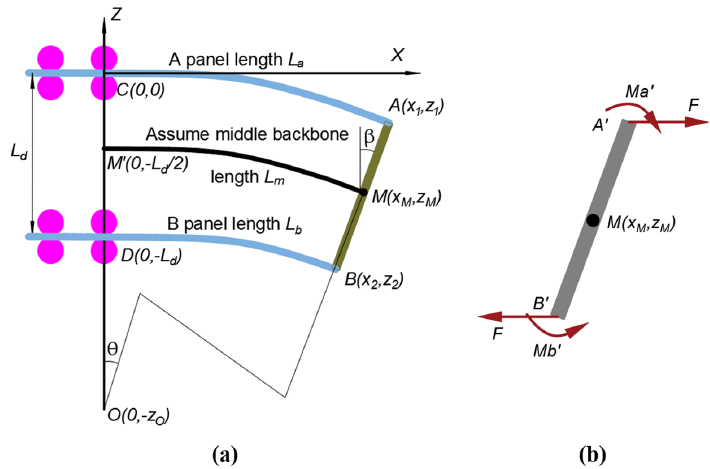
Figure 4. Planar parallel continuum robot and static analysis of the moving platform: ( a ) A virtual backbone that runs through the middle axis of the two panels; ( b ) A pushing force at point A and a pulling force at point B. (cid:1) Table 1 records the experimental data in terms of panel lengths L a and L b . In the ex ‐ periment, both panels start from 150 mm and end at 400 mm. In total, there are five series with an increment of 50 mm for L b , and within each series L a changes in an increment of 50 mm. For series 1, L b is at the initial position of 150 mm and L b changes from 200 mm to 400 mm in an increment of 50 mm. For series 2, L b advances to 200 mm and L a changes from 250 mm to 400 mm in an increment of 50 mm. Note that this robot is symmetric along the horizontal axis; L a does not have to start from the initial position at 150 mm, as this case is already covered by series 1. For series 3, 4 and 5, L b advances to 250 mm, 300 mm and 350 mm, respectively, while L a starts after the respective L b values for the same reason.